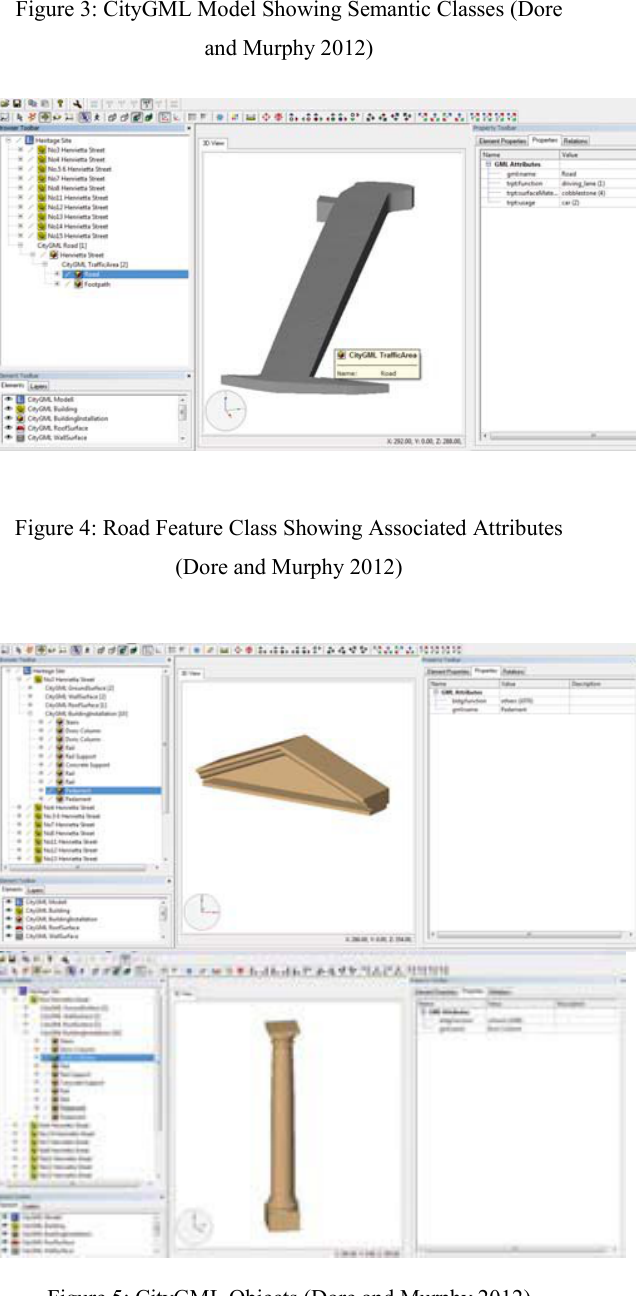
Figure 2: HBIM of Henrietta Street Dublin (modelled from scan in figure 1 and exported to Sketchup)